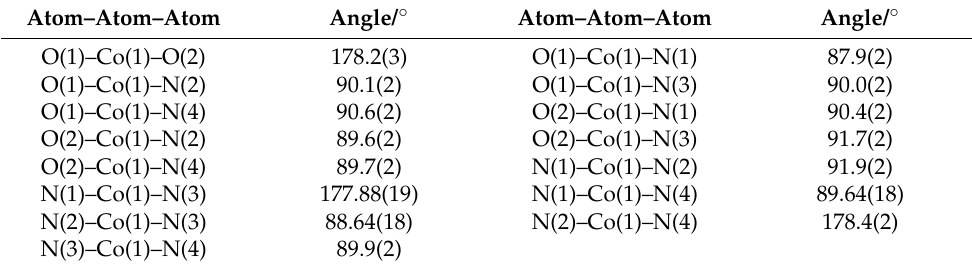
Table 5. Selected angles for 2